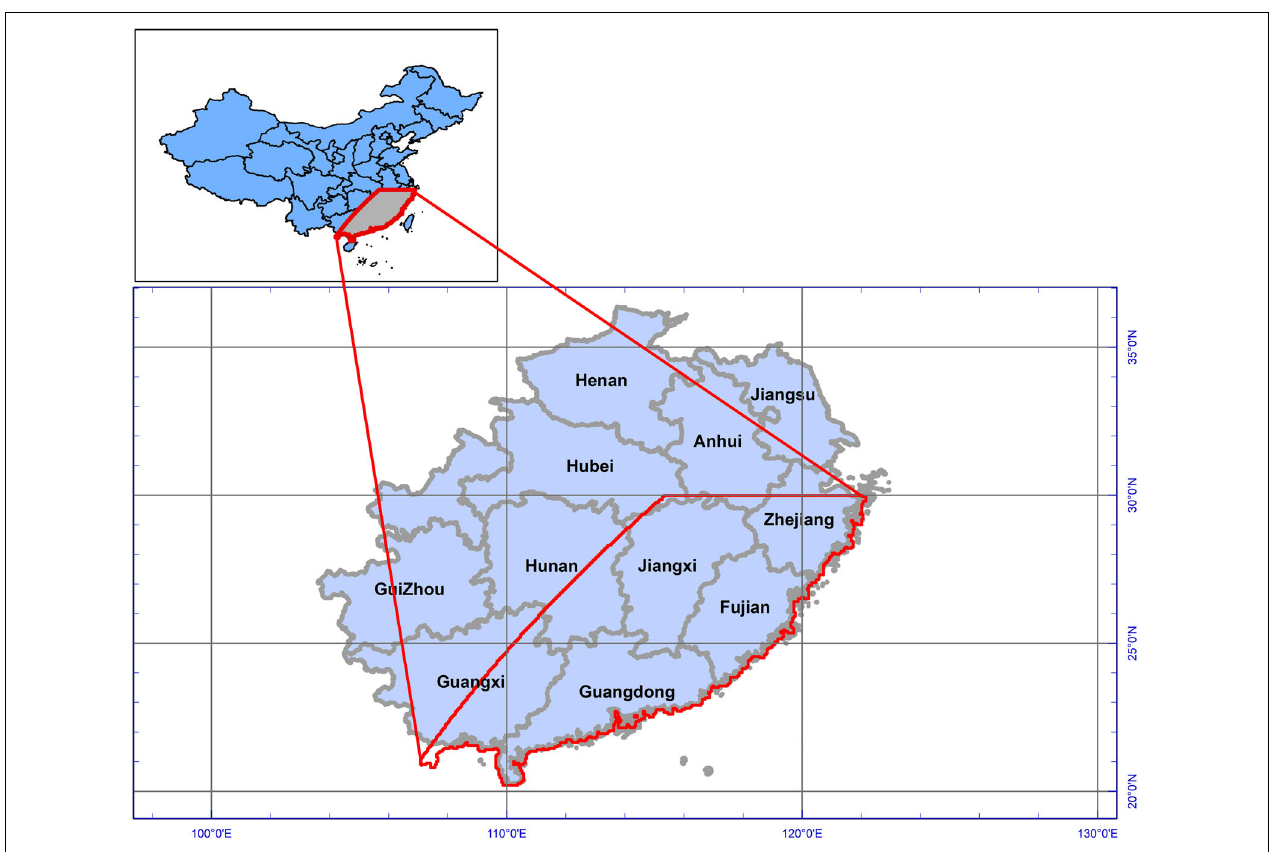
FIGURE 1 | Study area, location, and administrative coverage of study